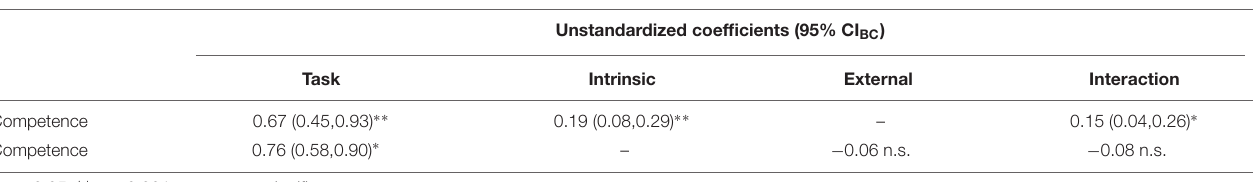
TABLE 2 | Simple moderation for task goal orientation models.